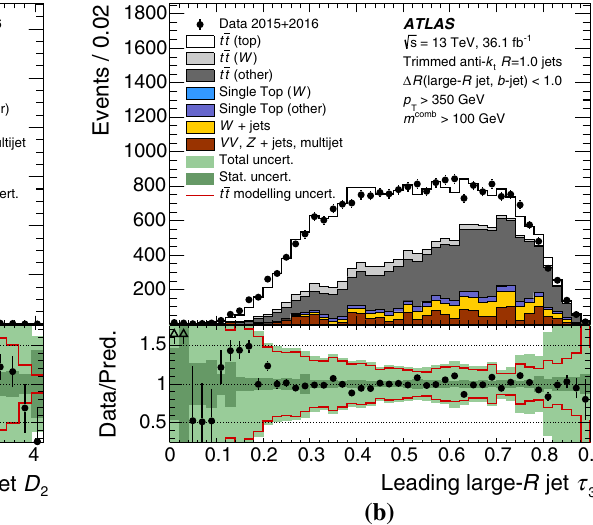
Fig. 11 A comparison of the observed data and predicted MC distri- butions of the anti- k t R = 1.0 trimmed jet D 2 ( a ) and τ 32 ( b ) for the W -boson and top-quark selections, respectively, in a sample enriched in lepton+jets t ¯ t events. Simulated distributions are normalised to data. The t ¯ t sample is divided into a set of subsamples (e.g. t ¯ t (top)) based on